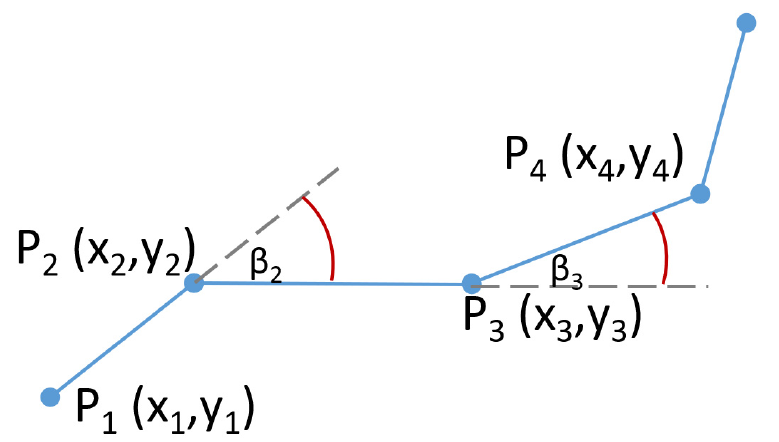
Figure 4. Types of tracklets. The panels ( a – c ) show a vehicle ′ s tracklet when traveling on a straight road, a bend, and a U ‐ turn, respectively. The panel ( d ) shows an erratic tracklet tracked from a non ‐ vehicle object.